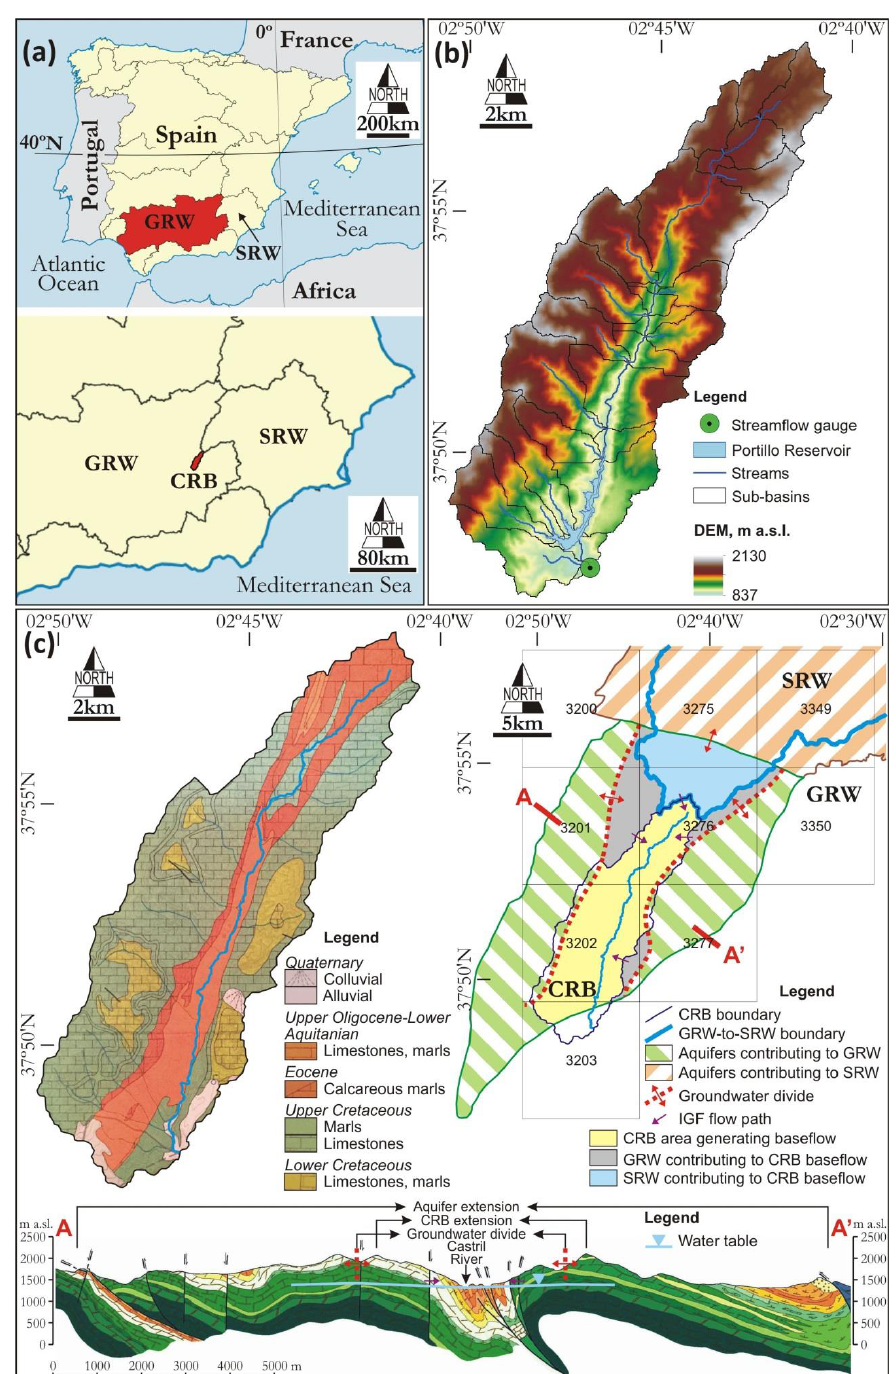
Figure 1. ( a ) Location of the Castril River basin (CRB) within the Guadalquivir River watershed (GRW) in southern Spain, adjacent to the Segura River watershed (SRW). ( b ) Discretization of the CRB and 29 sub-basins using the 25 m resolution Digital Elevation Model (DEM) from the Spanish National Geographic Institute, showing other features cited in the text. ( c ) After the Geological Survey of Spain (IGME) (1988, 1995, 2001) [50–52] and direct field observations, a hydrogeological map of the CRB (scale 1:200,000), the schematic hydrogeological functioning of the CRB and the hydraulically connected upstream GRW and SRW contributing areas, a hydrogeological cross-section A–A (cid:48) showing aquifer dimensions, CBR location, groundwater divides and flow paths, and the 10 km × 10 km cells for distributed net aquifer recharge (R) in the part of continental Spain [34,42] covered in the study area was